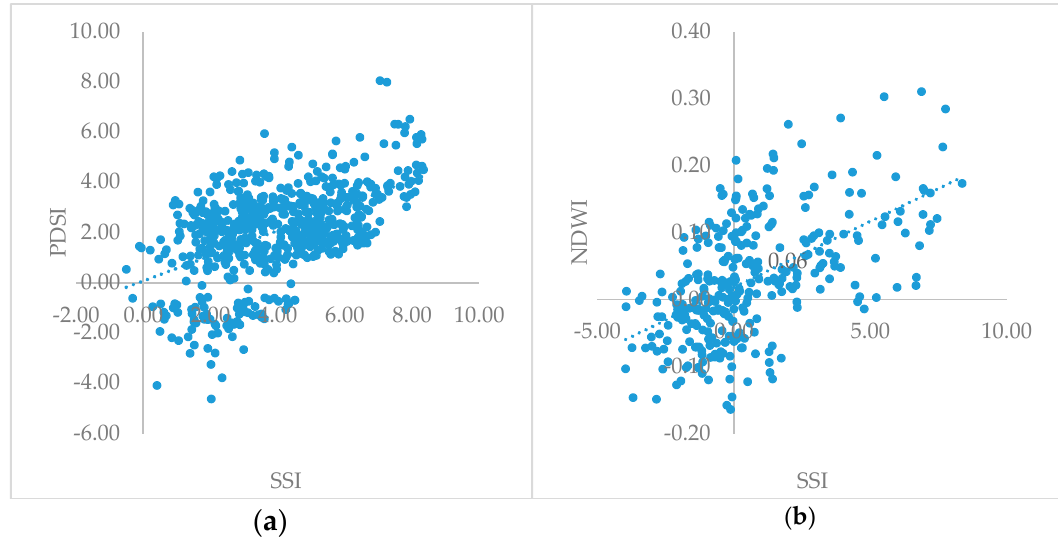
Figure 3. ( a ) Scatter plot for April 2015. The correlation between SSI and PDSI is moderate (r = 0.52); ( b ) Scatter plot for 1 to 3 April 2015. The correlation between SSI and NDWI is strong (r = 0.56).